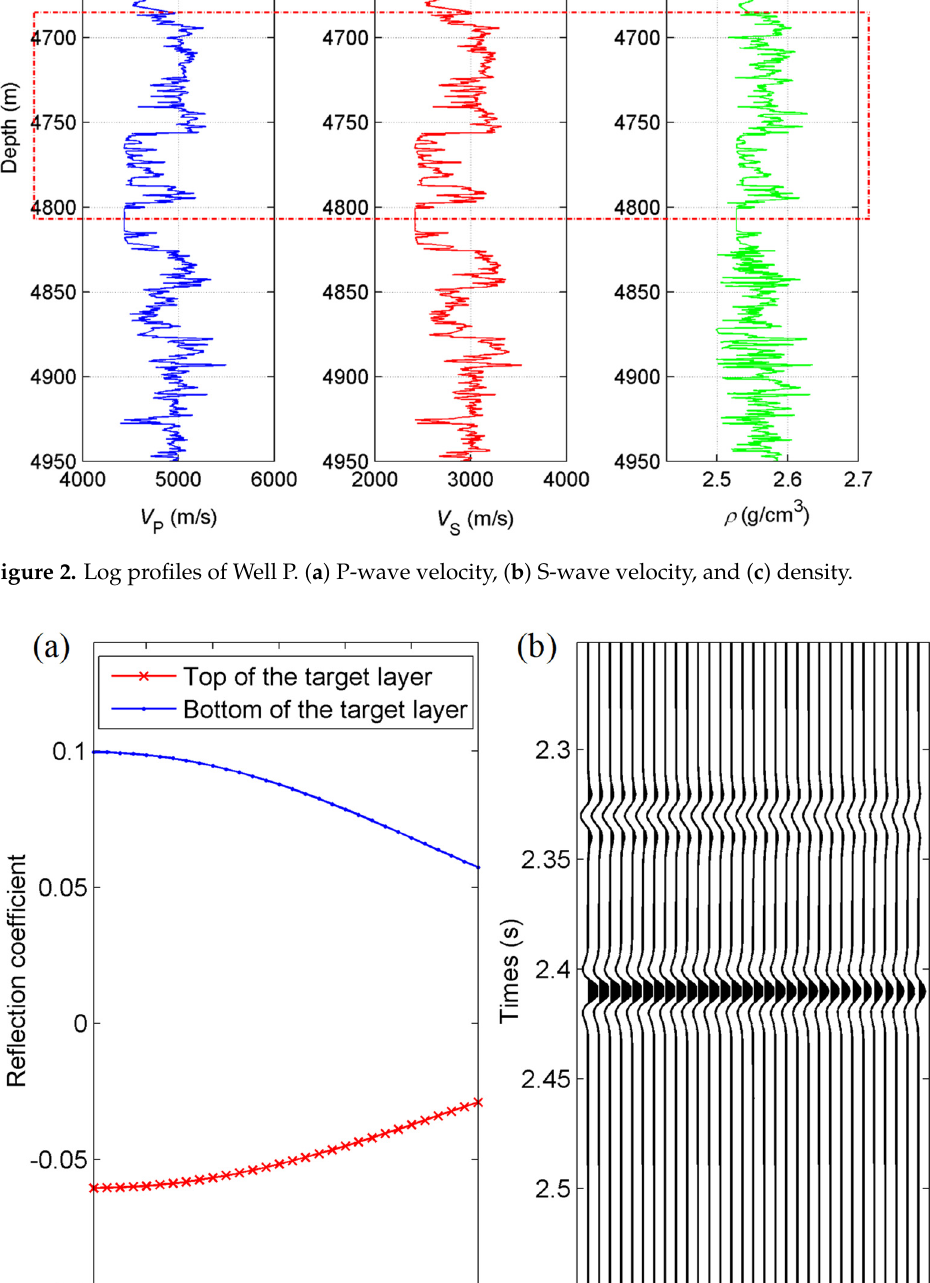
Figure 3. ( a ) AVO curves and ( b ) synthetic seismic records of the target layer.